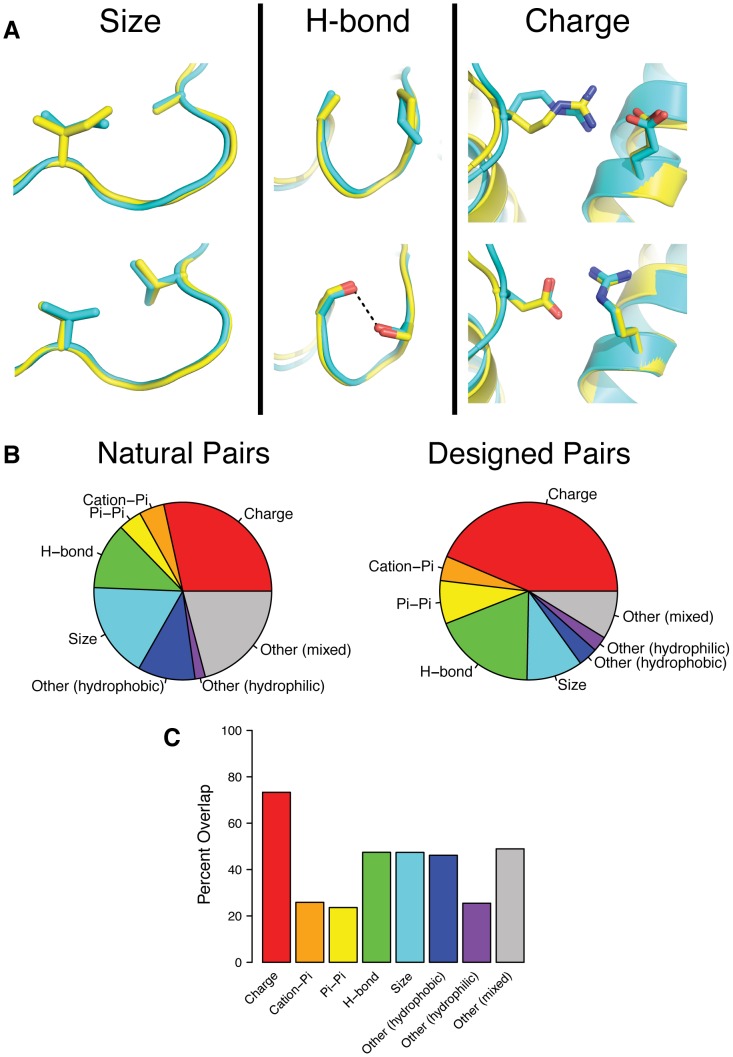
Covariation mechanisms of natural and designed covarying pairs.A) Representative examples of covariation mechanisms in both natural and designed sequences. Models from flexible backbone design (Backrub, kT = 0.9) are shown in cyan and x-ray crystal structures are shown in yellow. The left panel shows covariation due to size, the middle panel shows covariation due to hydrogen bonding and the right case shows covariation due to charge. The top and bottom rows for each panel show different amino acid pairs in the same positions but in different proteins. B) Pie charts showing the distribution of covariation mechanisms for pairs that covary in both natural and designed sequences. The left pie chart shows covariation mechanisms for natural pairs and the right shows covariation mechanisms for designed pairs. See the methods for a definition of the mechanism classification. C) Bar plot showing the percent overlap between natural and designed pairs for each covariation mechanism.